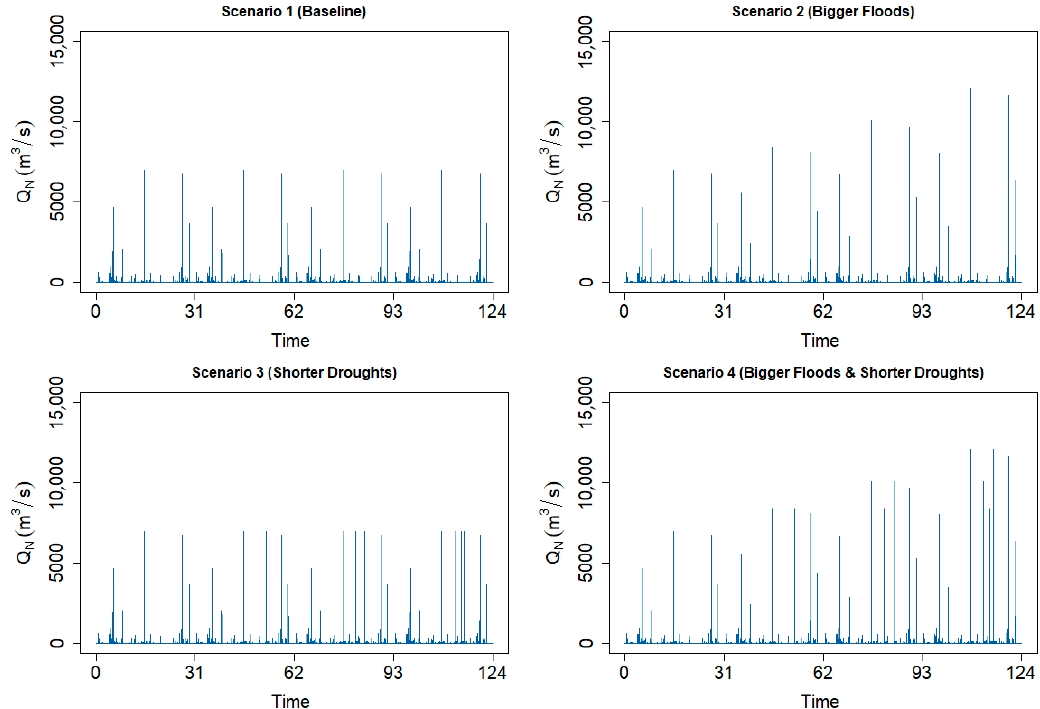
Figure 10. Hydrographs of natural river discharge into the Dam corresponding to di ff erent future hydrological extremes scenarios.